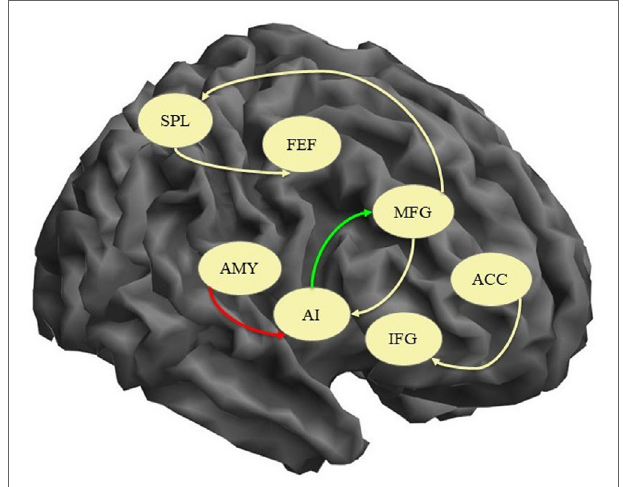
FigUre 1 | Connections with significant difference between patients and healthy controls. Yellow arrow, connection significantly different between the groups but not significantly different than 0; green arrow, connection significantly higher in controls; red arrow, connection significantly higher in patients; AI, anterior insula; IFG, inferior frontal gyrus; MFG, middle frontal gyrus; FEF, frontal eye field; ACC, anterior cingulate cortex; SPL, superior parietal lobe; AMY,